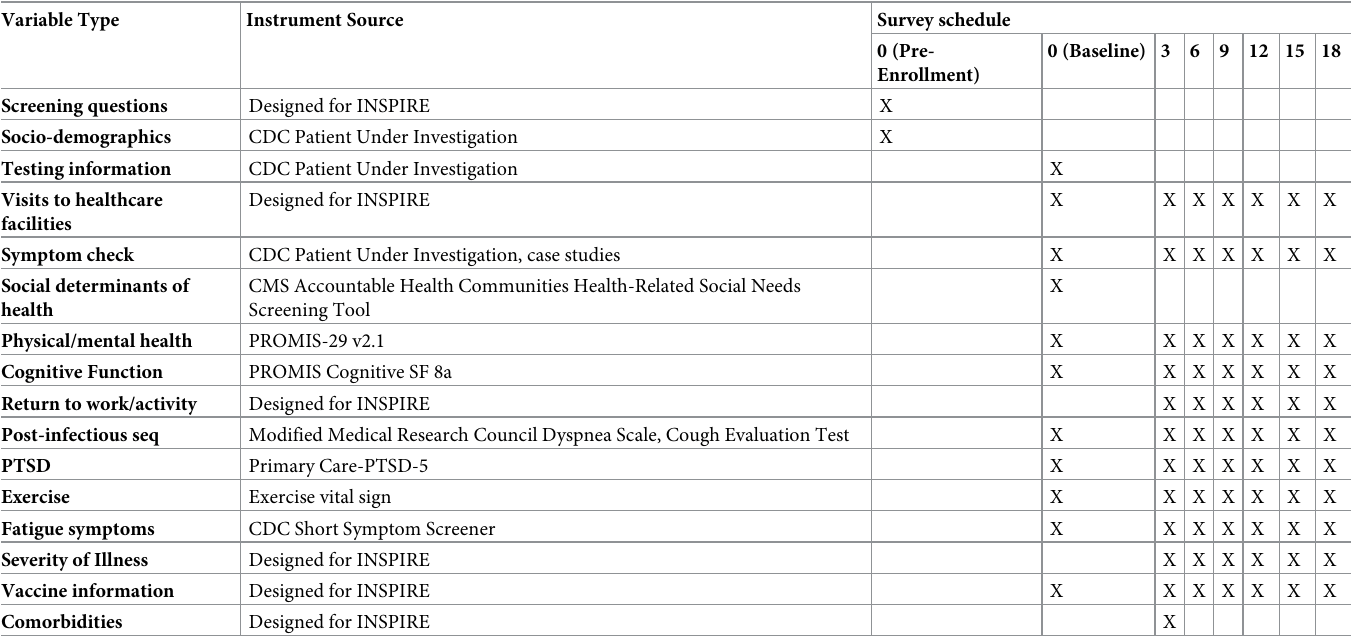
Table 3. Summary of survey variables collected, instrument sources, and schedule of survey delivery. Variable